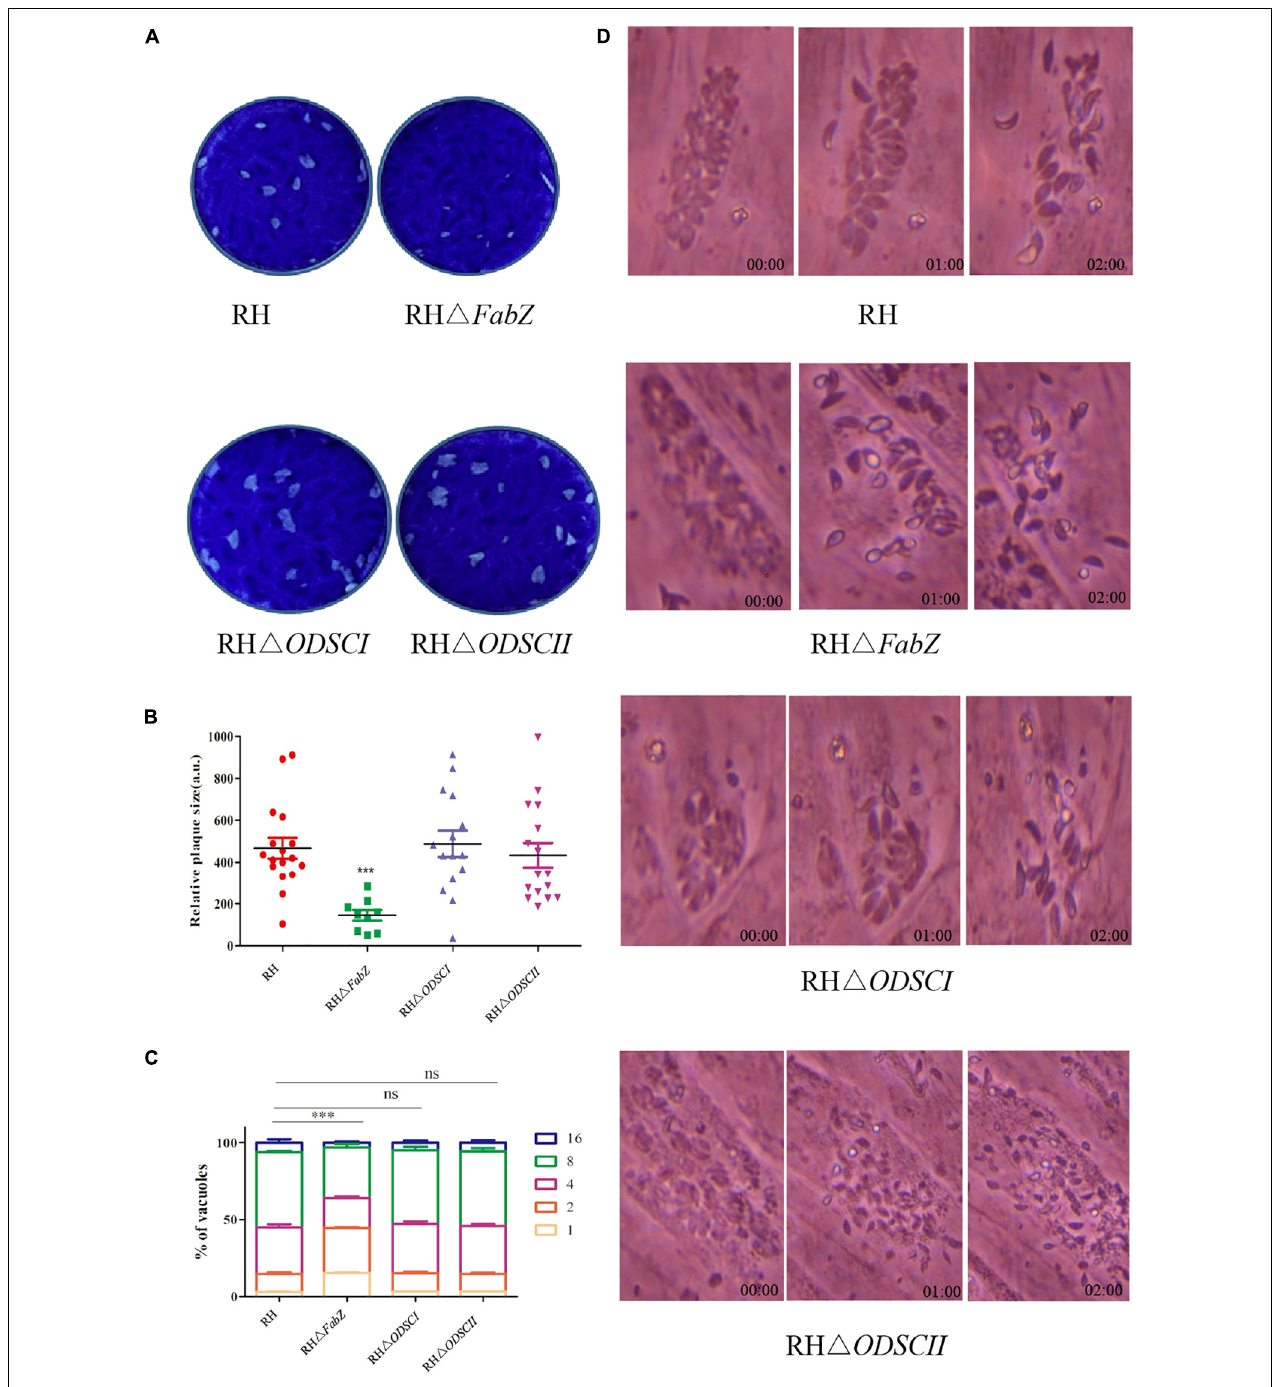
FIGURE 3 | Characterization of the growth kinetics of the knockout strains in vitro. (A) Representative images of the plaque assay of HFFs infected with RH WT strain and mutant strains (RH (cid:49) FabZ , RH (cid:49) ODSCI, and RH (cid:49) ODSCII ) for 7 days. (B) Plaque’s size presented as arbitrary units (a. u.). The relative size of RH (cid:49) FabZ plaque was significantly smaller and the number of plaque was fewer that of RH WT strain, and there was no significant difference between RH (cid:49) ODSCI or RH (cid:49) ODSCII and RH WT strain. (C) The replication of T. gondii in HFFs was quantified by counting the number of T. gondii tachyzoites (1, 2, 4, 8, 16) per vacuole 24 h after infection with RH WT strain, RH (cid:49) FabZ , RH (cid:49) ODSCI, or RH (cid:49) ODSCII strain. RH (cid:49) FabZ replication was significantly inhibited, while RH (cid:49) ODSCII and RH (cid:49) ODSCII strains had similar intracellular replication kinetics to WT strain. (D) HFFs were infected with RH WT strain, RH (cid:49) FabZ, RH (cid:49) ODSCI, or RH (cid:49) ODSCII strain for 36 h, followed by treatment with 3 µ M calcium ionophore A23187 to monitor the egress of tachyzoites at 0, 1, and 2 min after treatment. The results showed that the egressed pattern of WT strain was similar to that of all mutant strains. The data are presented as means ± SEMs ( n = 3 in triplicates). ∗∗∗ P < 0.001; ns, non-significant by Student’s t -test and Gehan-Breslow-Wilcoxon test.